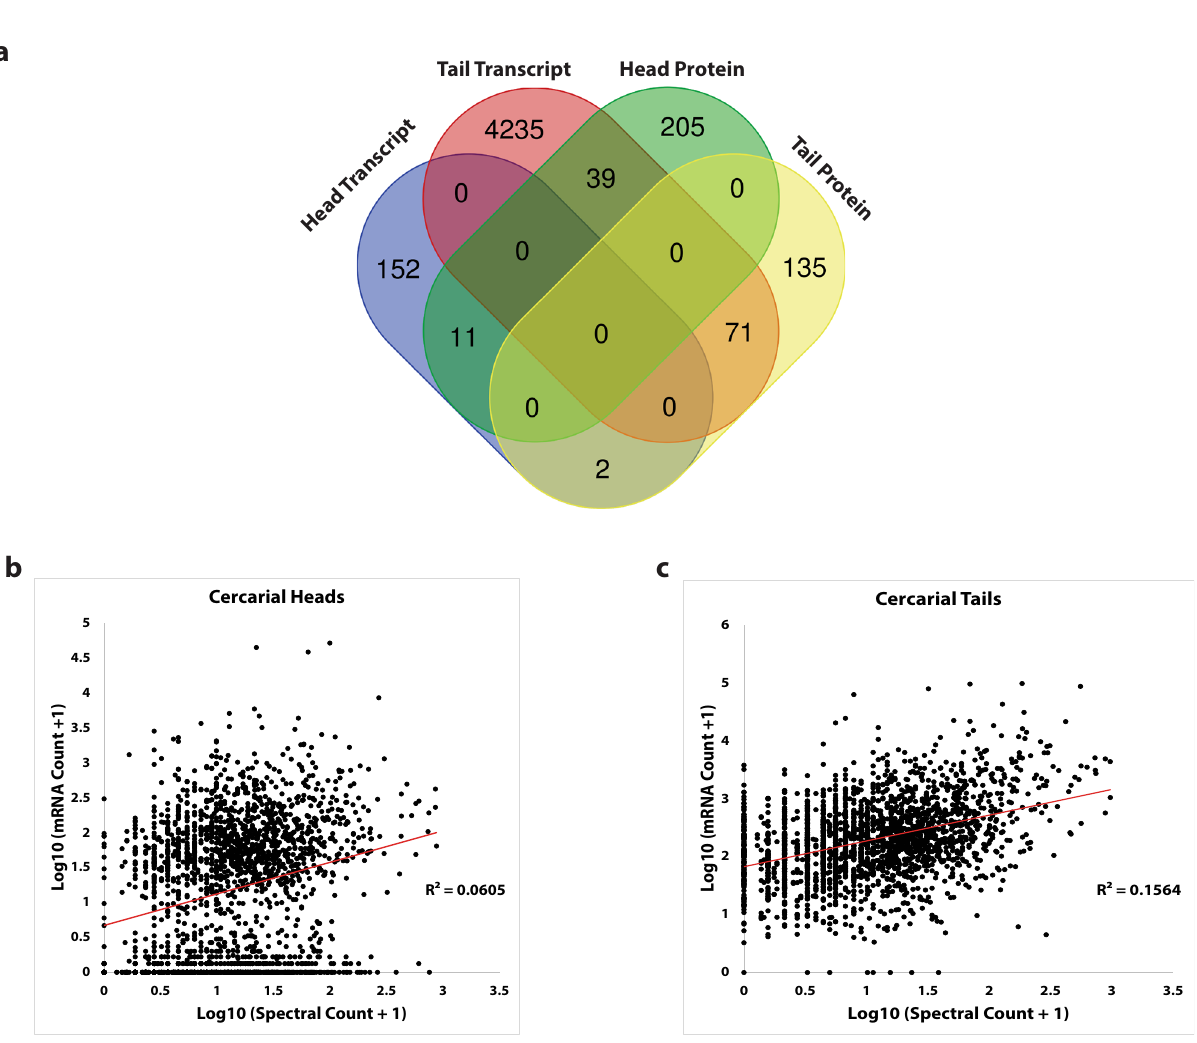
Fig. 6 Translation and transcription are not highly correlated in cercarial heads and tails. a shows the intersection of differentially expressed transcripts and proteins in cercarial heads and tails. b , c show a scatter plot of normalized abundance from transcript along the X-axis and normalized abundance from protein along the Y-axis for heads and tails individually. The R 2 = 0.0605 and R 2 = 0.1564 with red linear fi t lines show little positive correlation between the transcript and protein abundance in cercarial heads ( b ) and cercarial tails ( c ), respectively All supporting data is contained in Supplementary Data 1. Replication n = 3 independent biological